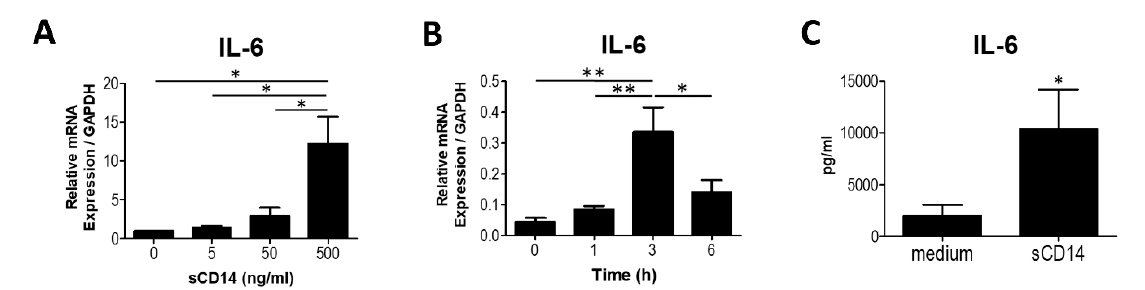
Figure 1. Soluble CD14 induces the expression and secretion of IL-6 by fibroblast-like synoviocytes from RA patients (RA-FLS). ( A ) RA-FLS were cultured with sCD14 (0–500 ng / mL) for 6 h. After culture, relative expression of IL-6 mRNA was measured by real-time PCR and levels normalized to GAPDH mRNA. Data are shown as means ± SEM in five RA-FLS. ( B ) RA-FLS were cultured with sCD14 (500 ng / mL) for 1, 3, and 6 h. After culture, relative expression of IL-6 mRNA was measured by real-time PCR and levels normalized to GAPDH mRNA. Data are shown as means ± SEM in five RA-FLS. Statistical significance was analyzed by Tukey’s Multiple Comparison Test (* p < 0.05, ** p < 0.01). ( C ) RA-FLS were cultured with sCD14 (500 ng / mL) for 24 h. IL-6 protein in supernatant was measured by ELISA. Data are shown as means ± SEM in three RA-FLS. Statistical significance was analyzed by unpaired t -test (* p <